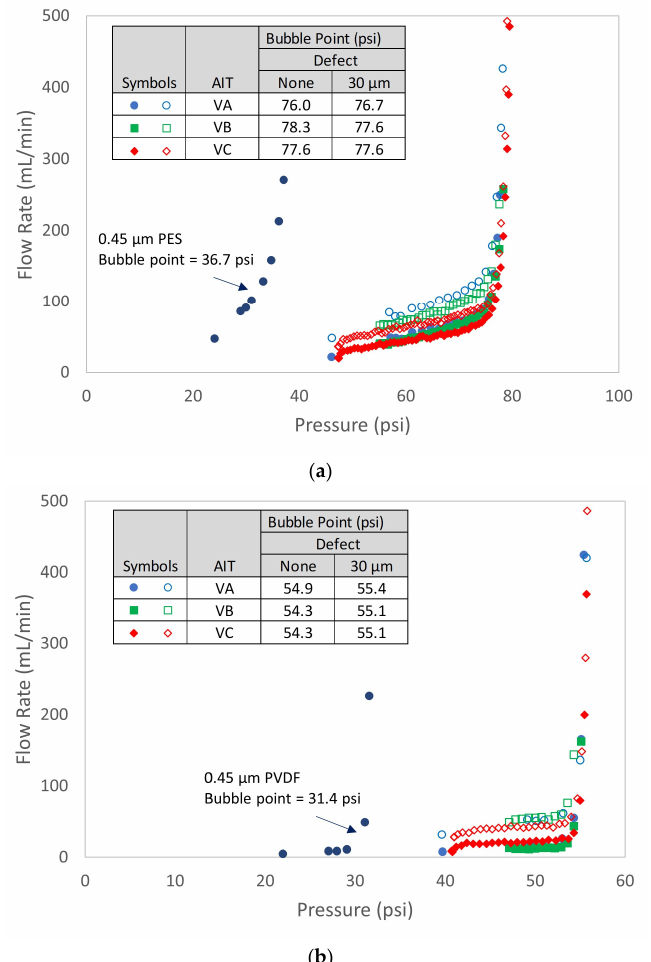
Figure 9. Flow rate vs. pressure comparison between a 0.2 µm defect-free device and a device containing a 30 µm laser hole, along with defect-free 0.45 µm device: ( a ) SE filter; ( b ) SD filter. While the laser hole defects did not result in depressed bubble points (where values were reported), the air diffusion rates of the filters containing laser holes were elevated compared to the integral filters. The diffusion value at the pressure where a filter had a diffusion specification could, in principle, be used as an indicator of filter integrity. However, the bubble point test algorithm does not necessarily measure the diffusion rate at the pressure at which the diffusion specification is stated by the filter vendor (assuming the filter has a diffusion specification) since the starting pressure and pressure increments vary from vendor to vendor and recipe to recipe. Furthermore, for AITs to complete a bubble point test in a reasonable amount of time, the measurement of diffusive flow rate